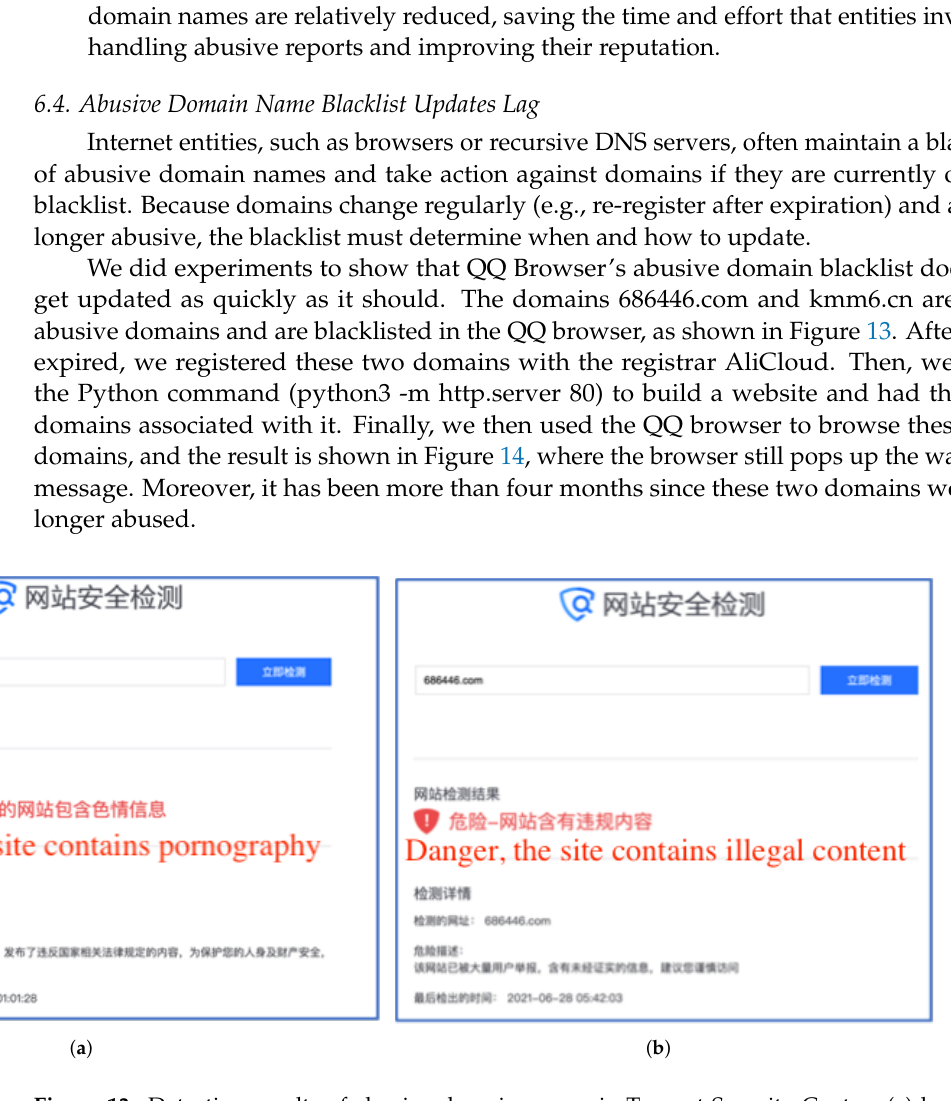
Figure 13. Detection results of abusive domain names in Tencent Security Center. ( a )